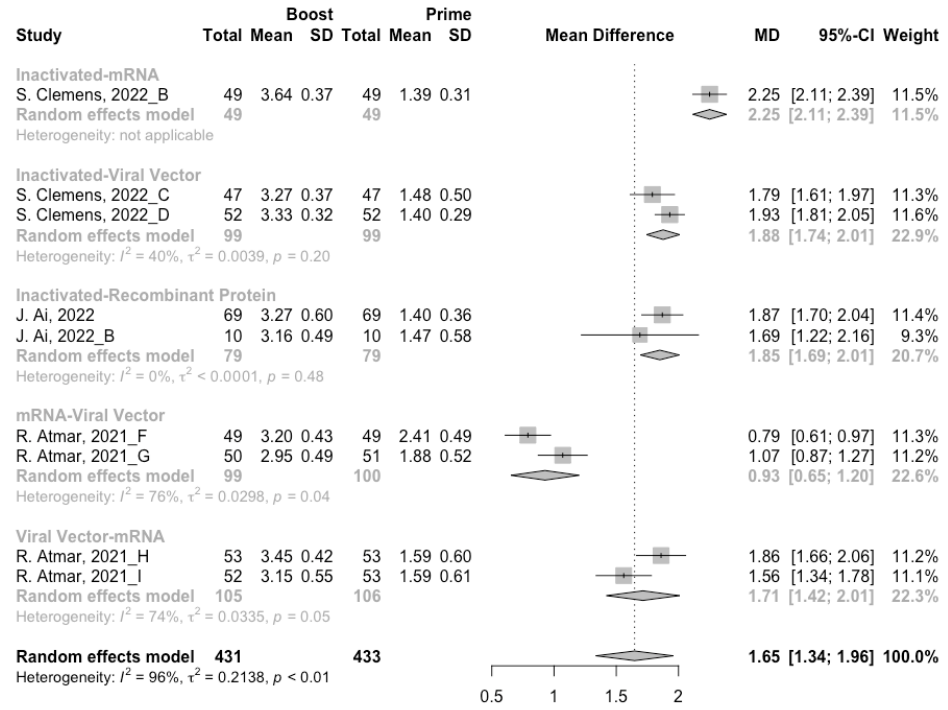
Figure 8. Forest plot of the pooled log-transformed neutralization antibody titers before and after heterologous booster vaccination.